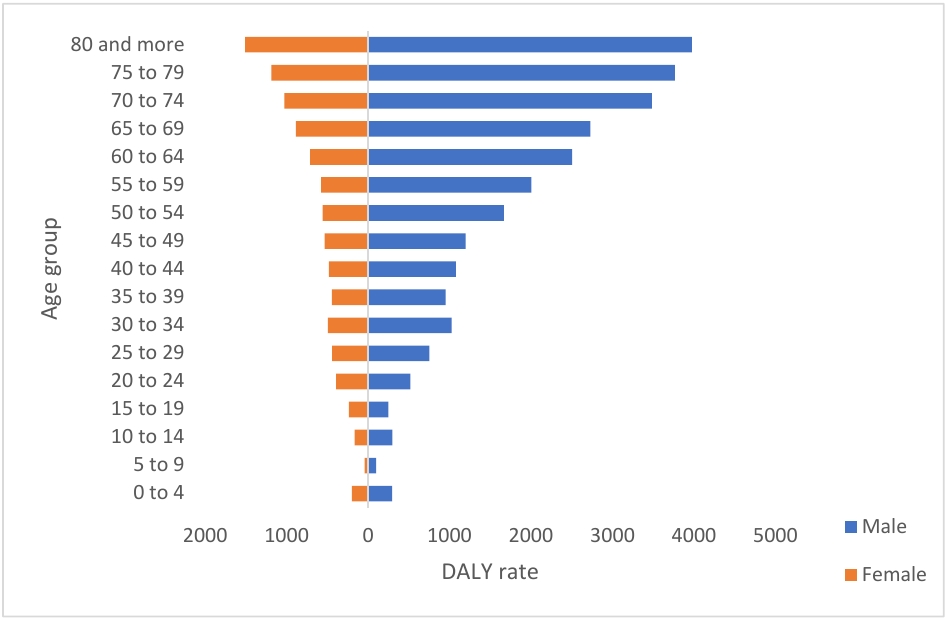
Figure 3. DALY rate by sex an age groups, Colombia, 2010–2018. The health gap in the study period of each of the departments of Colombia, due to the loss of years of life, determined by the DALYs was greater, in magnitude, in the territorial entities of Amazonas (1857.1 CI 95% 1177.1–2389.6), Risaralda (1317.1 CI 95% 982.6–